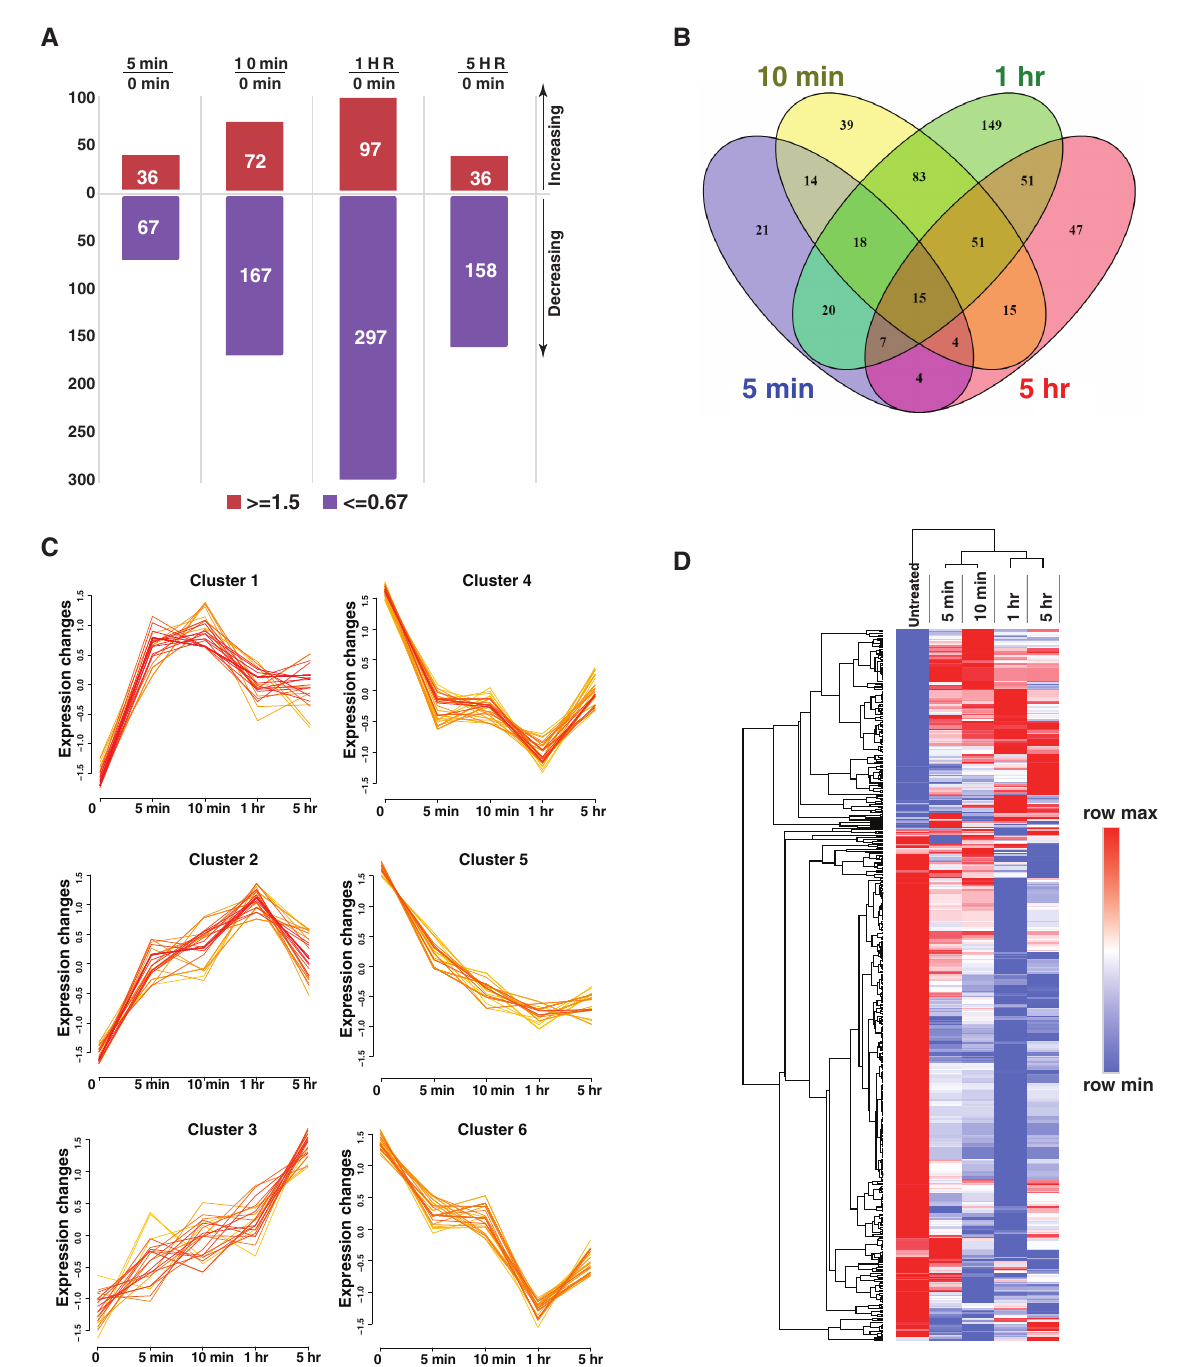
Figure 3. Dynamic regulation of tyrosine phosphorylation induced by the activation of GAS6/AXL signaling cascades. ( A ). Plot showing the number of upregulated and downregulated tyrosine phosphorylation sites at the indicated time points. ( B ). Venn diagram showing the overlap of regulated tyrosine phosphorylation sites at different times. ( C ). Fuzzy C-means clustering showing clusters of phosphotyrosine sites with dynamic regulation patterns. ( D ). A heatmap visualizing the hierarchical clustering of phosphotyrosine sites regulated by AXL. Each column represents the intensity at the indicated time points after GAS6